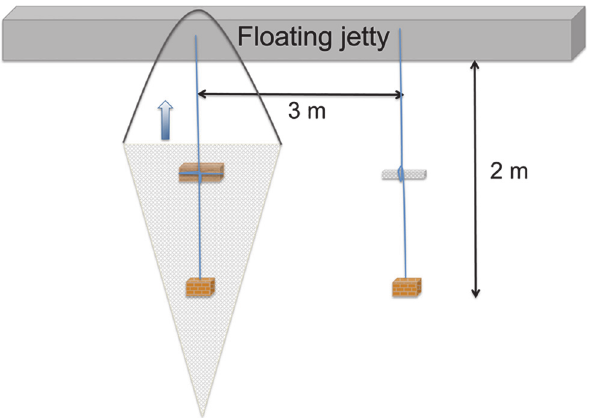
Fig 1. Field experiment. Experimental set up used to study detection of waterborne chemical cues by shipworm larvae in the field. Net bags with and without wooden panels were submerged at 1 m depth from a floating jetty. A vertical tow with a hoop-net (90 μ m, illustrated by a grey triangle) was used to filter the water around the net bags. In each tow, the hoop-net including the net bag and its line was lifted to the surface.